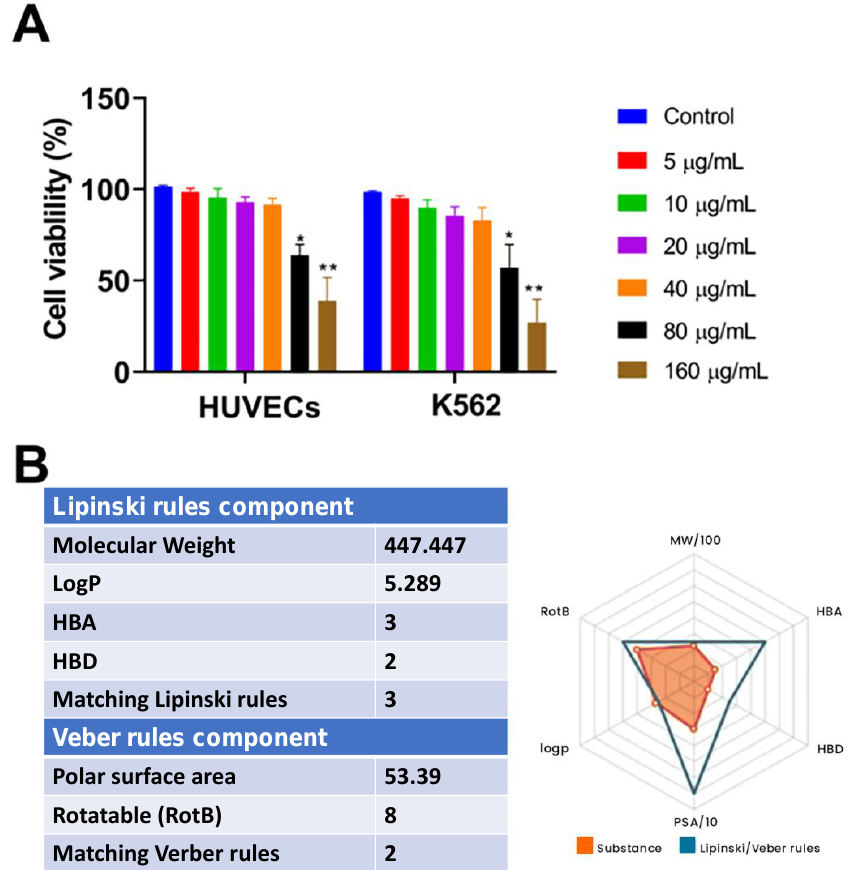
Figure 6. Cytotoxicity ( A ) and drug-likeness ( B ) evaluation of TD4. * p < 0.05, ** p < 0.01, n =3.